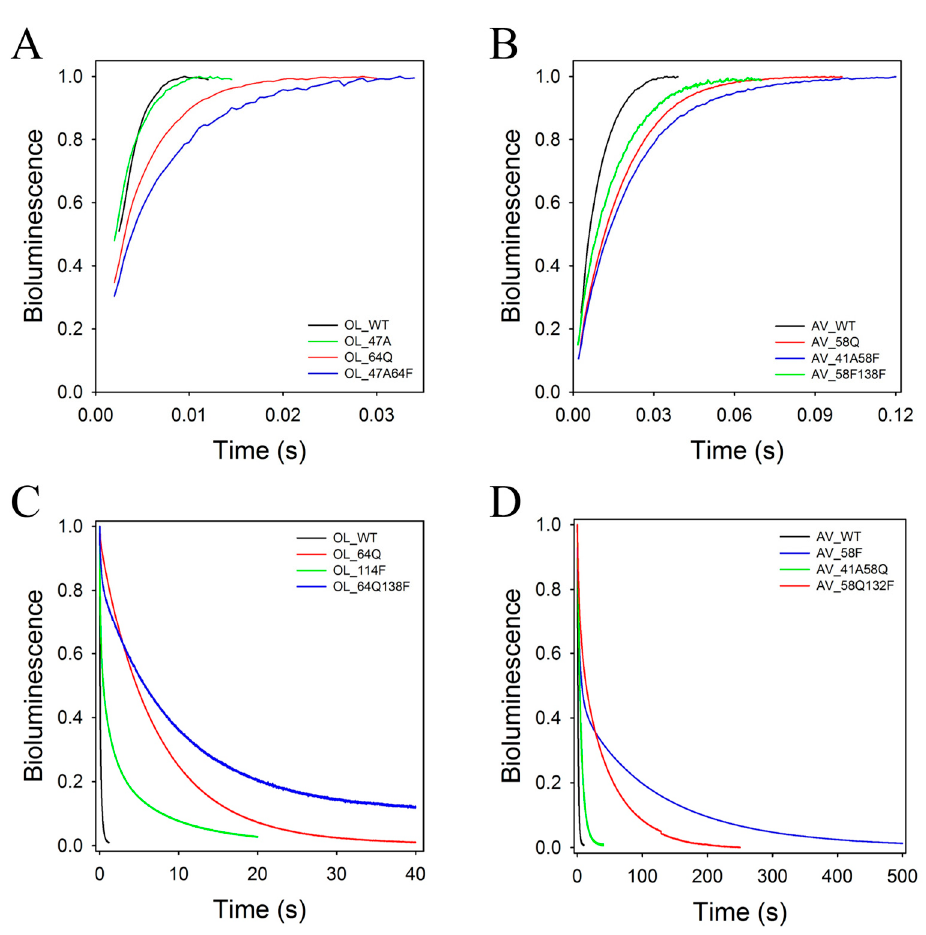
Figure 3. High-speed ( A , B ) and low-speed ( C , D ) stopped-flow plots of the bioluminescence signals of obelin ( A , C ), aequorin ( B , D ), and their mutants. The curves are individual